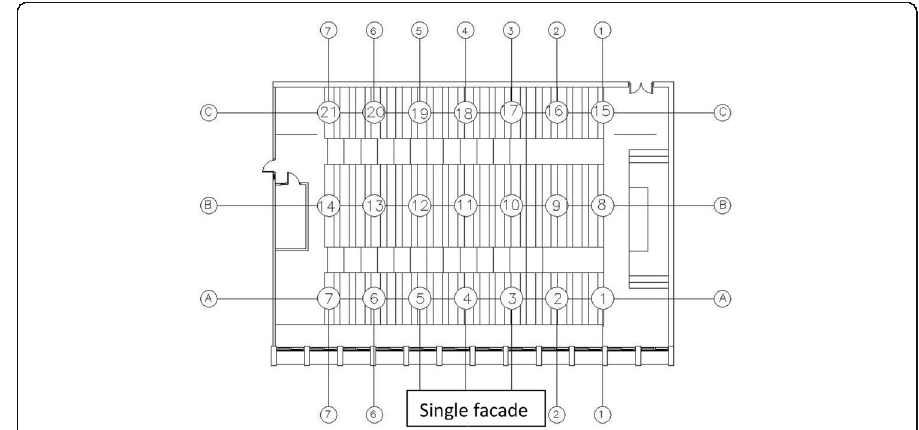
Fig. 4 Measurement 21 points at level 1.20 m breathing zone (source: the authors)